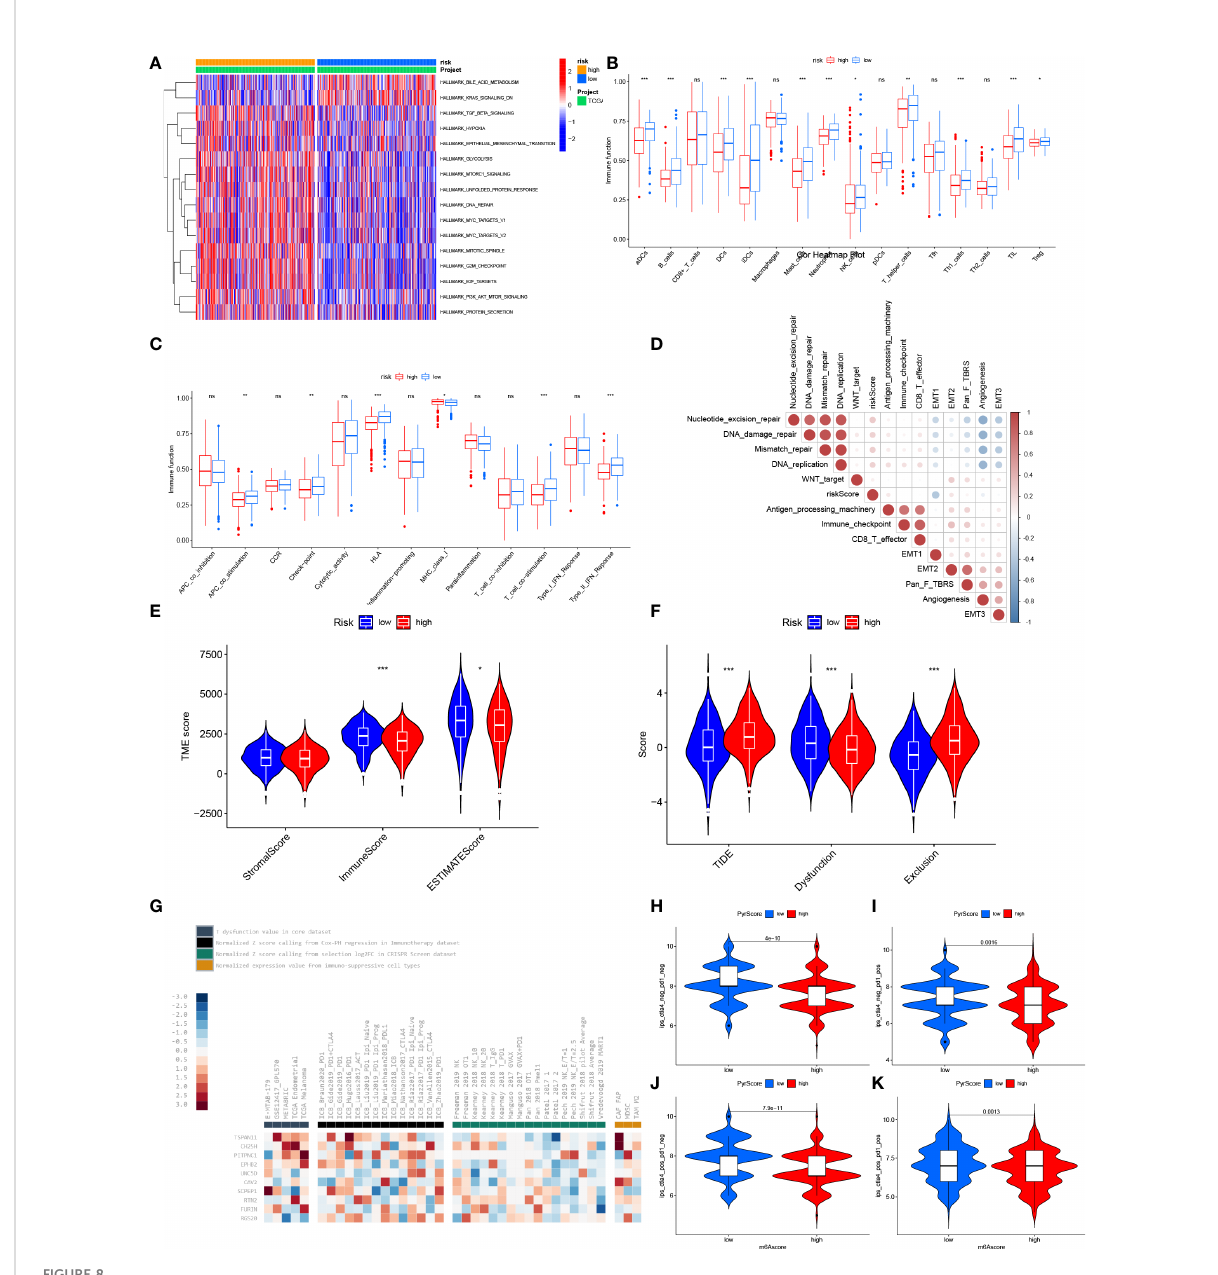
FIGURE 8 Characteristic of TME between low- and high-risk group. (A) GSVA enrichment analyses based on the Hallmarker gene sets showed the states of biological processes in low- and high- risk groups. (B) The abundance of tumor in fi ltrating immune cells in low- and high-risk groups. (C) The difference of immune functions between low- and high-risk groups. (D) Correlation between risk score and tumor-related functions. (E) Differences of ESTIMATE score, stromal score and immune score between low- and high- risk score. (F) Differences of T cell dysfunction, exclusion and TIDE in low- and high-risk score. (G) Enrichment of 10 selected genes in T cell dysfunction level, ICB response outcome, phenotypes in genetic screens and cell types promoting T cell exclusion. Difference of IPS with CTLA4- and PD-1- (H) , CTLA4- and PD-1+ (I) , CTLA4+ and PD-1 (J) and CTLA4+ and PD-1+ (K) between low- and high-risk group. "* ” means that p < 0.05; “ ** ” means that p < 0.01; " “ *** ” means that p < 0.001; ns, no signi fi